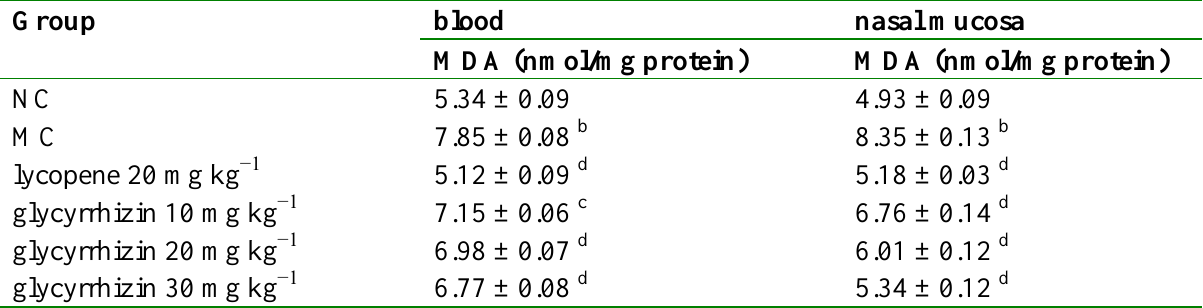
Table 3. Blood and nasal mucosa MDA levels in different groups.